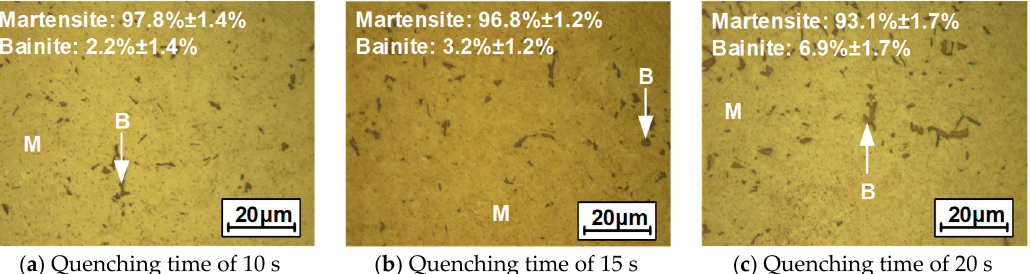
Figure 13. Microstructure for partially quenched part according to quenching time at heated tool